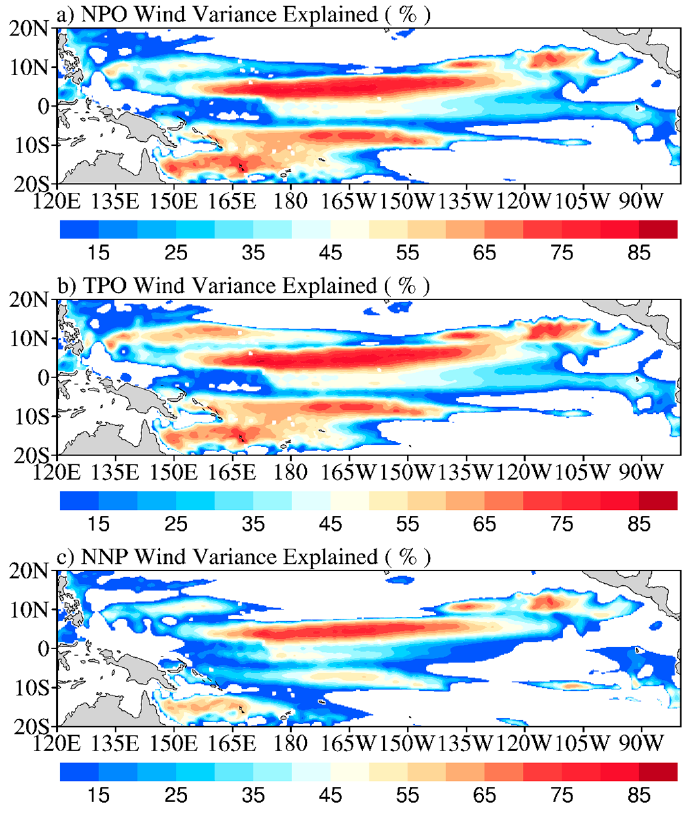
Figure 4. Contributions of different wind forcing to seasonal sea level variations: ( a ) the real monthly wind field; ( b ) the real wind field in the TPO and the climatic wind field in other regions; ( c ) the real wind field in other regions and the climatic wind field in the